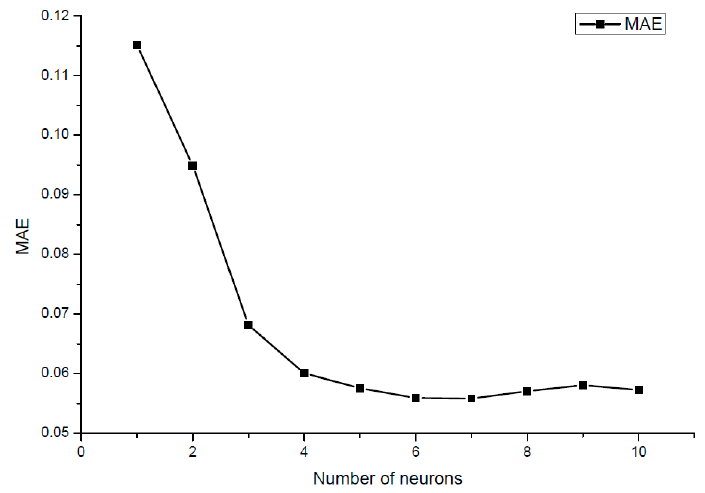
Figure 29. MEA versus hidden layer neurons performance curve.